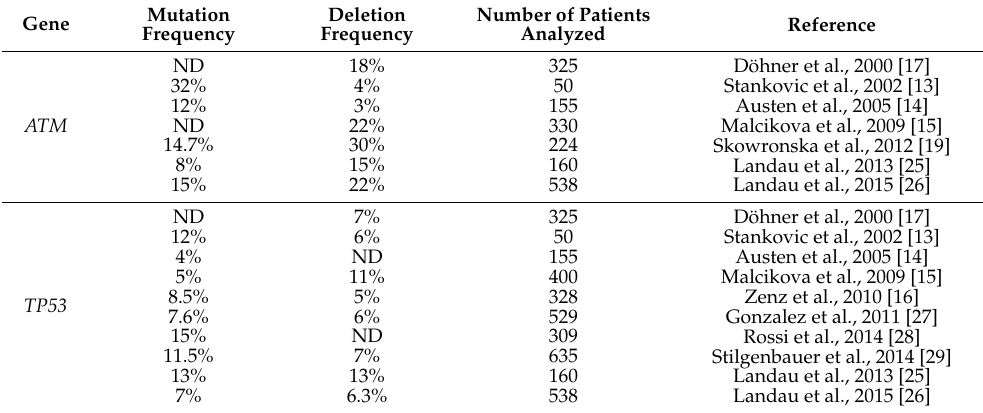
Table 1. Frequency of different p53 pathway alterations in patients with chronic lymphocytic